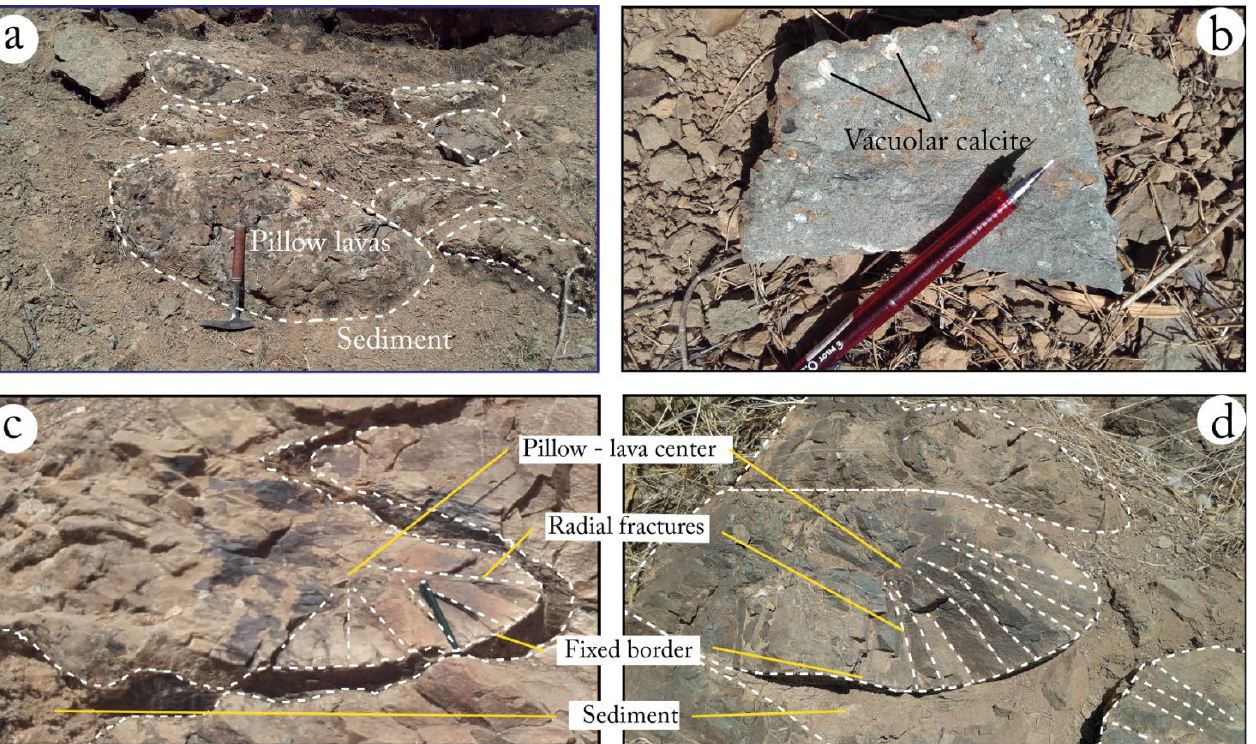
Figure 12. ( a ) Pillow-lavas outcrop, ( b ) vacuolar lava facies, ( c ) detailed pillow structure showing radial fractures and ( d ) pillow in contact with greenish pelites.